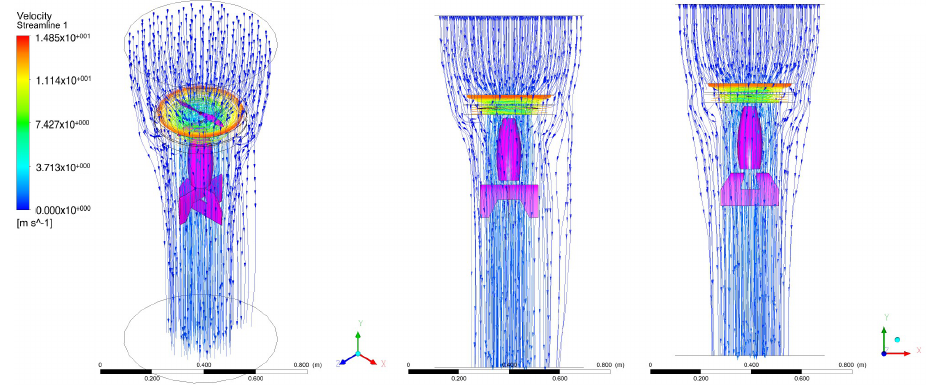
Figure 7. MCR UAV v3.0 velocity streamlines.